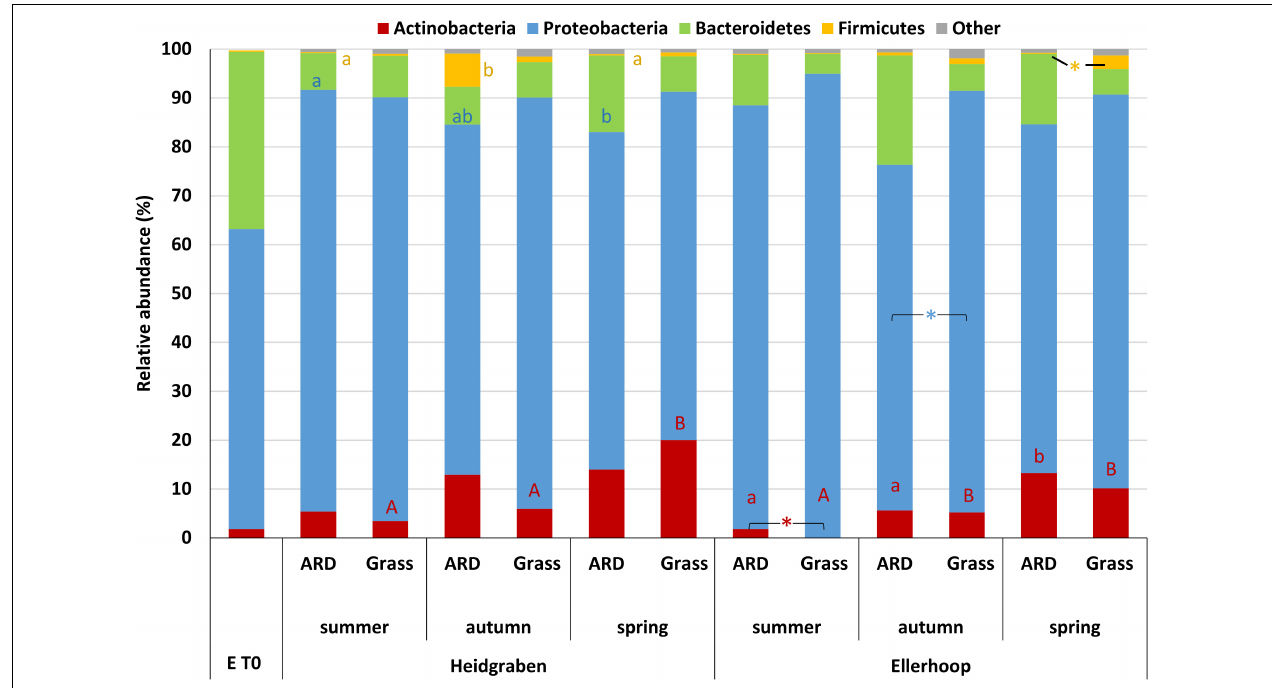
FIGURE 2 | Relative abundance of dominant phyla in roots of Bittenfelder plants grown in apple replant disease (ARD) plots or grass plots at Heidgraben and Ellerhoop taken in summer and autumn after planting or the following spring. Different letters indicate statistically significant differences within one site in ARD plots (lower case) or grass plots (upper case) between the seasons (DESeq2 analysis using a generalized linear model and multiple comparisons with p ≤ 0.05). Significant differences between ARD and grass within one season are indicated by an asterisk (DESeq2 analysis using a generalized linear model and pairwise comparisons with p ≤ 0.05). Different colored letters belong to the respective phyla. N numbers are shown in Table 2